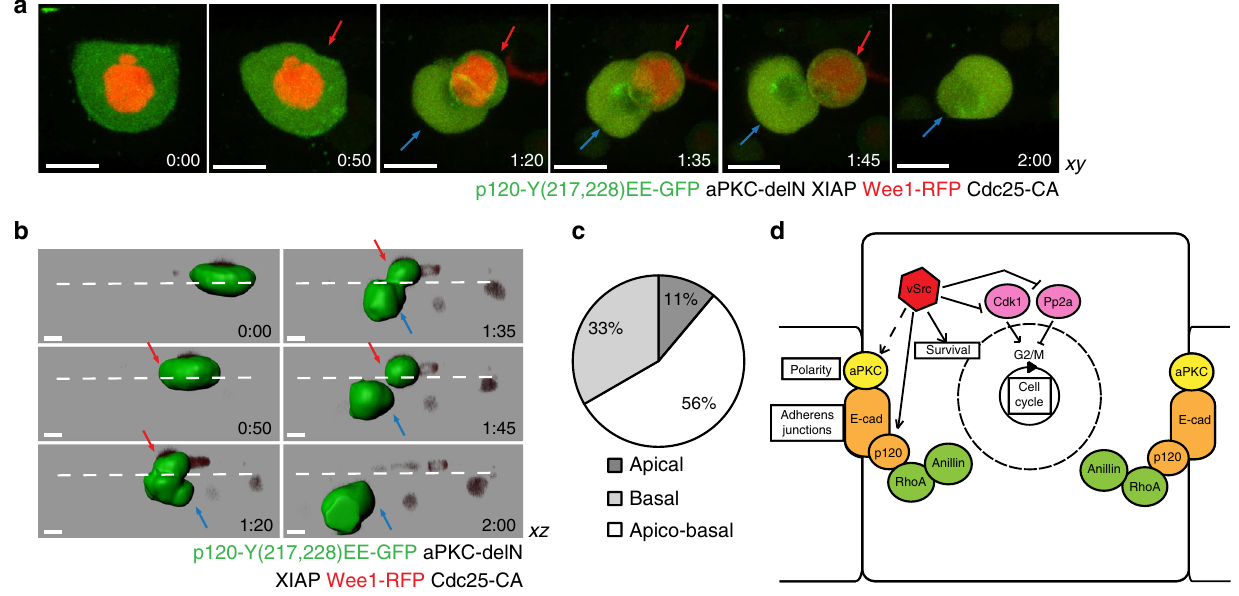
Fig. 9 Modulating the cell cycle, junctions and polarity mimics vSrc-like extrusion. a Time-lapse imaging of vSrc-like extrusion induced by coexpression of p120-mutEE, aPKC-delN and the apoptotic inhibitor XIAP in G2/M-arrested cells. Embryos were injected with a combination of the following constructs: dUAS:Cherry-Wee1;CA-Cdc25, dUAS:p120-mutFF;aPKC-delN and Krt18:XIAP. Movies were taken over 6 h. Frames were extracted from a representative movie at indicated times from the tailbud stage. The cell is undergoing an apicobasal split (apical part is marked with red arrows and the basal part with blue arrows). Scale bars, 15 µ m. b Time-lapse imaging of vSrc-like cell extrusion in a segmented using the Imaris software. The surface function was used to segment GFP-positive cells over time. In this cross section of the embryo ( xz view), the cell is undergoing an apicobasal split (apical part is marked with red arrows and the basal part with blue arrows). The dashed white line indicates the surface of the embryo. Scale bars, 10 µ m. c Quanti fi cation of the type of vSrc-like cell extrusion based on time-lapse imaging. Extrusion was induced by coexpression of p120-mutEE, aPKC-delN and the apoptotic inhibitor XIAP in G2/M-arrested cells. Fourteen embryos were imaged in four independent experiments (total number of extrusions: n p120EE,aPKC-delN,wee1,cdc25,XIAP = 27). d A schematic model of vSrc-driven cell extrusion. vSrc interferes with the cell cycle, and modulates adherens junctions, cell survival and apicobasal polarity, leading to apicobasal extrusion. vSrc-expressing cell becomes taller than its neighbours. Cell cycle regulators are hijacked; Pp2A is inactivated earlier in the cell cycle, but counteracting Cdk1 inhibition results in G2/M arrest instead of mitosis. The nuclear envelope becomes partially permeable and Anillin is recruited to the adherens junctions by modi fi ed p120-catenin, presumably through active RhoA. A contractile junctional ring assembles parallel to the plane of the epithelium, constricts in early mitosis and releases the cell from the epithelium. vSrc-mediated modulation of the apicobasal polarity complex (e.g. aPKC) promotes the predominantly apical direction of extrusion. Immediate cell death is avoided due to vSrc promoting cell